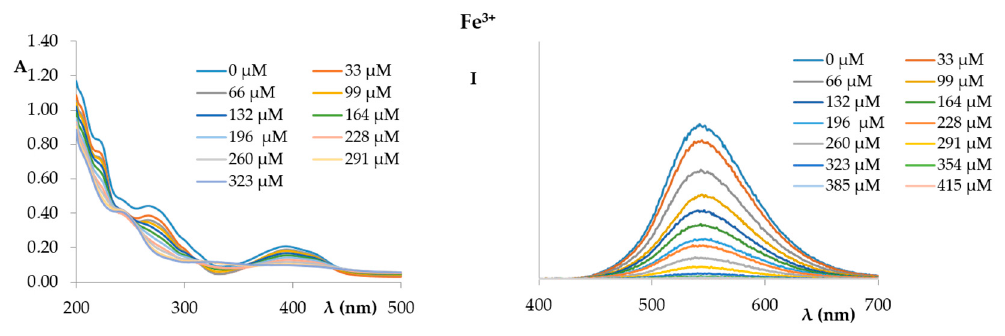
Figure 6. Fluorescence (excitation at 366 nm) spectra of compound 1 (1.72 × 10 − 5 M in EtOH:phosphate buffer) titrated with increasing amounts of a copper nitrate solution (( left ) 1.0 × 10 − 3 M; ( right ) 1.0 × 10 − 4 M).